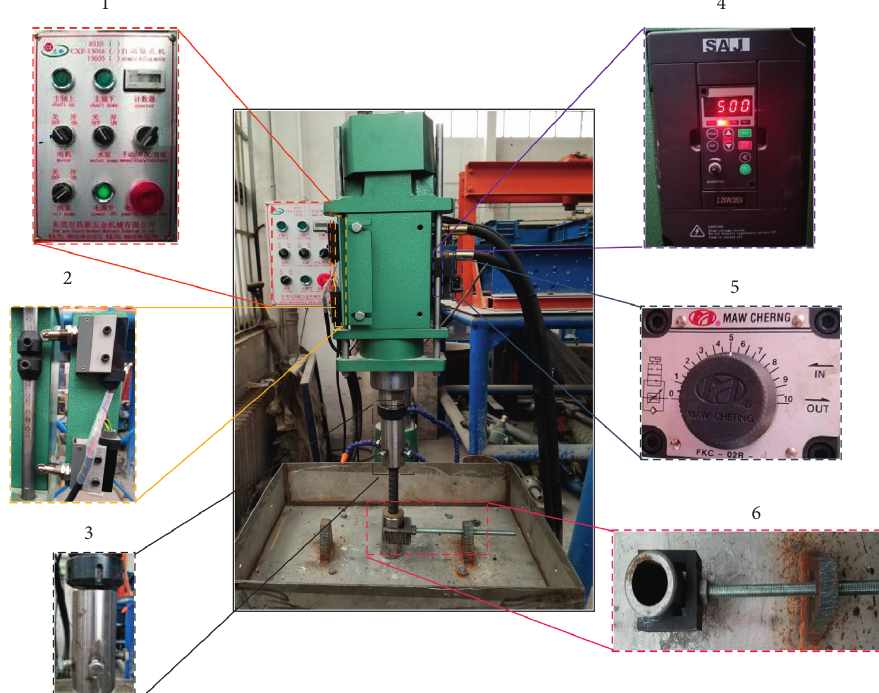
Figure 13: Photographs of the mixing and anchorage equipment, showing details of the (1) operation control panel, (2) distance sensor, (3) chuck conversion device, (4) speed control panel, (5) thrust control knob, and (6) sleeve fixing